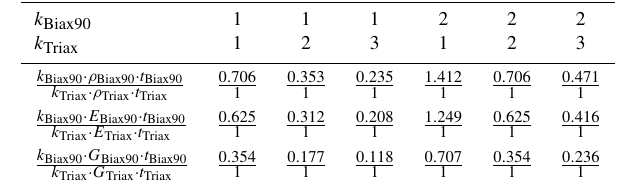
Table 5. Ratio between Biax90 ◦ and Triax layers for density and stiffness contribution, considering different layer